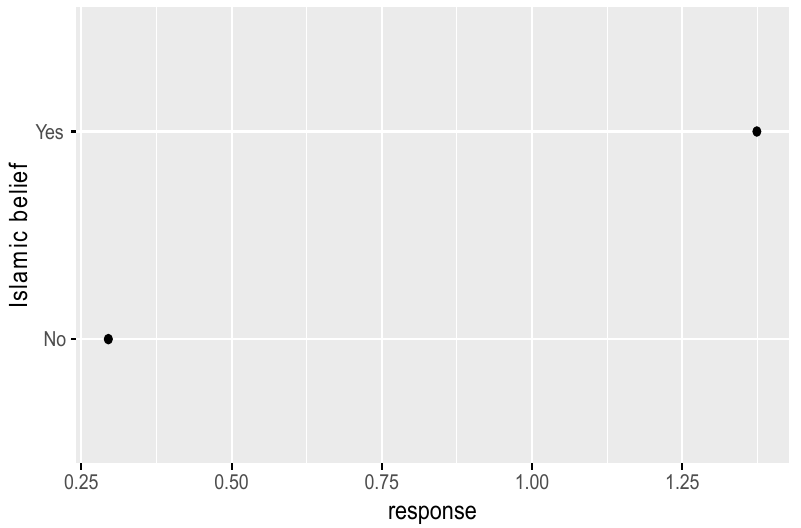
Figure 5. Zero-inflated regression coefficient of social attitude-2. Figure 6. Zero-inflated regression coefficient of social attitude-2. Figure 6. Zero-inflated regression coefficient of social attitude-2.